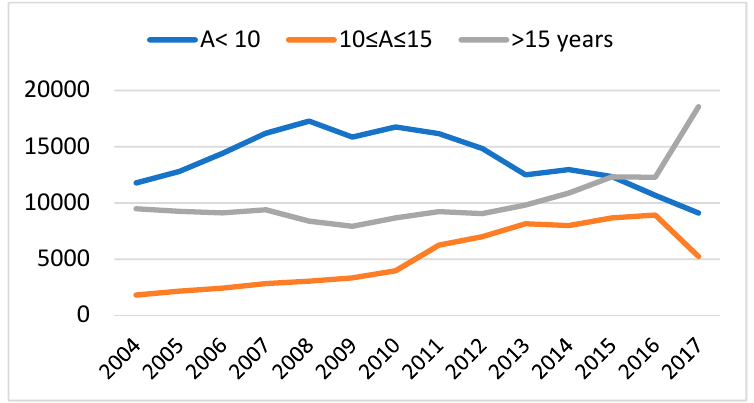
Figure 5. Evolution of emissions of Spanish tugboat fleet, by groups of age. Source: authors. By groups of size (measured in GT), the fleet of tugboats of between 300 and 400 GT was the one that produced the most emissions for the period analyzed, except for the year 2017, when the tugboats of over 400 GT were the ones that polluted the most (see Figure 6) the x-axis shows the emissions of tons of CO 2 and the y-axis show the years.